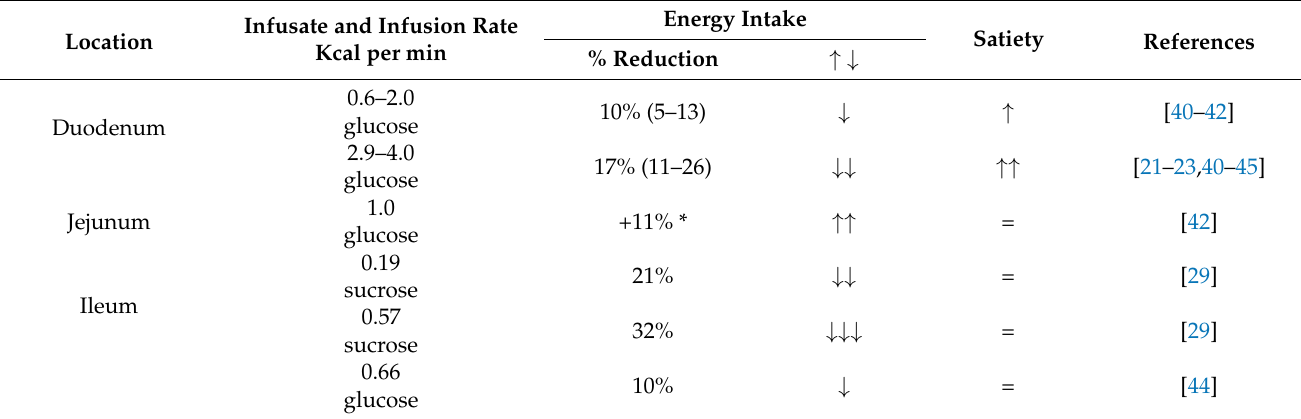
Table 3. Effect of infusion of carbohydrate (glucose or sucrose) into duodenum, jejunum or ileum on energy intake and